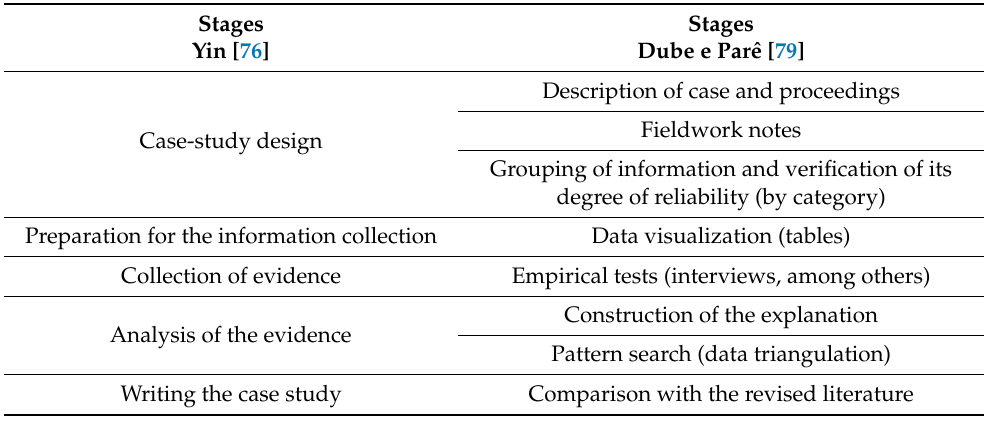
Table 1. Analysis of qualitative